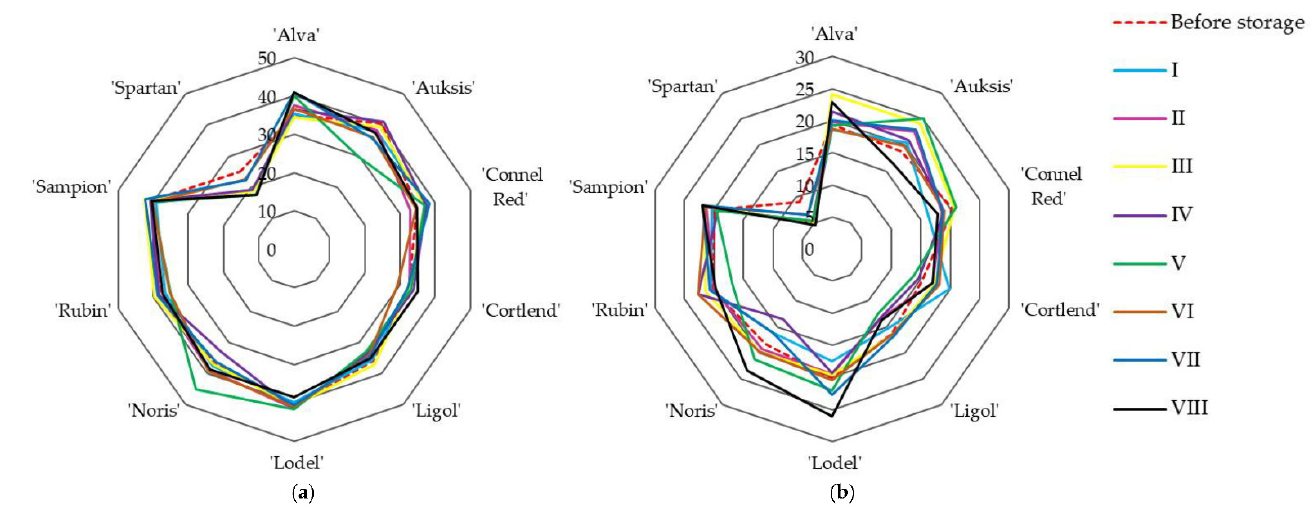
Figure 1. Variability of co-ordinates measured in NBS units in apple peel before and after storage in CA: ( a ) redness (a*) co-ordinate; ( b ) yellowness (b*) co-ordinate.